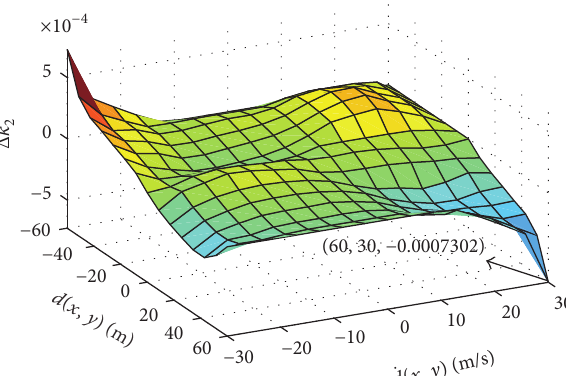
Figure 5: Input-output surface for the fuzzy logic unit.